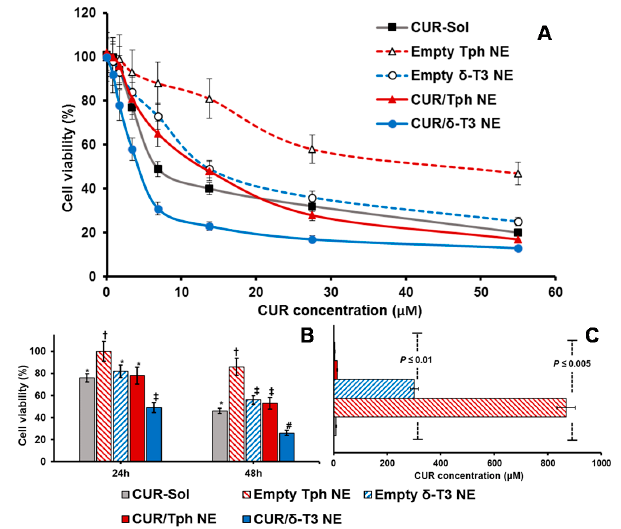
Figure 7. Concentration- and time-dependent cytotoxicity assays against OVCAR-8 cell cultures. Microplate-based CellTiter Blue ® assay of human ovarian adenocarcinoma cells, OVCAR-8 cells, measured for different empty and CUR-loaded VE-nanoemulsions vs. CUR solution serving as free drug control ( A ) at CUR-equivalent concentration range of 0.85–55 μ M after incubation for 48 h; or ( B ) at “cross-section” CUR-equivalent concentration of 25 μ M, over co-incubation period of for 24–48 h; along with ( C ) IC 50 values calculated for each preparation type, after 48 h treatment, at 37 °C, 5% CO 2 conditions ( n = 3–4, mean ± SE, mean values denoted with unlike symbols are statistically different, p ≤ 0.05).